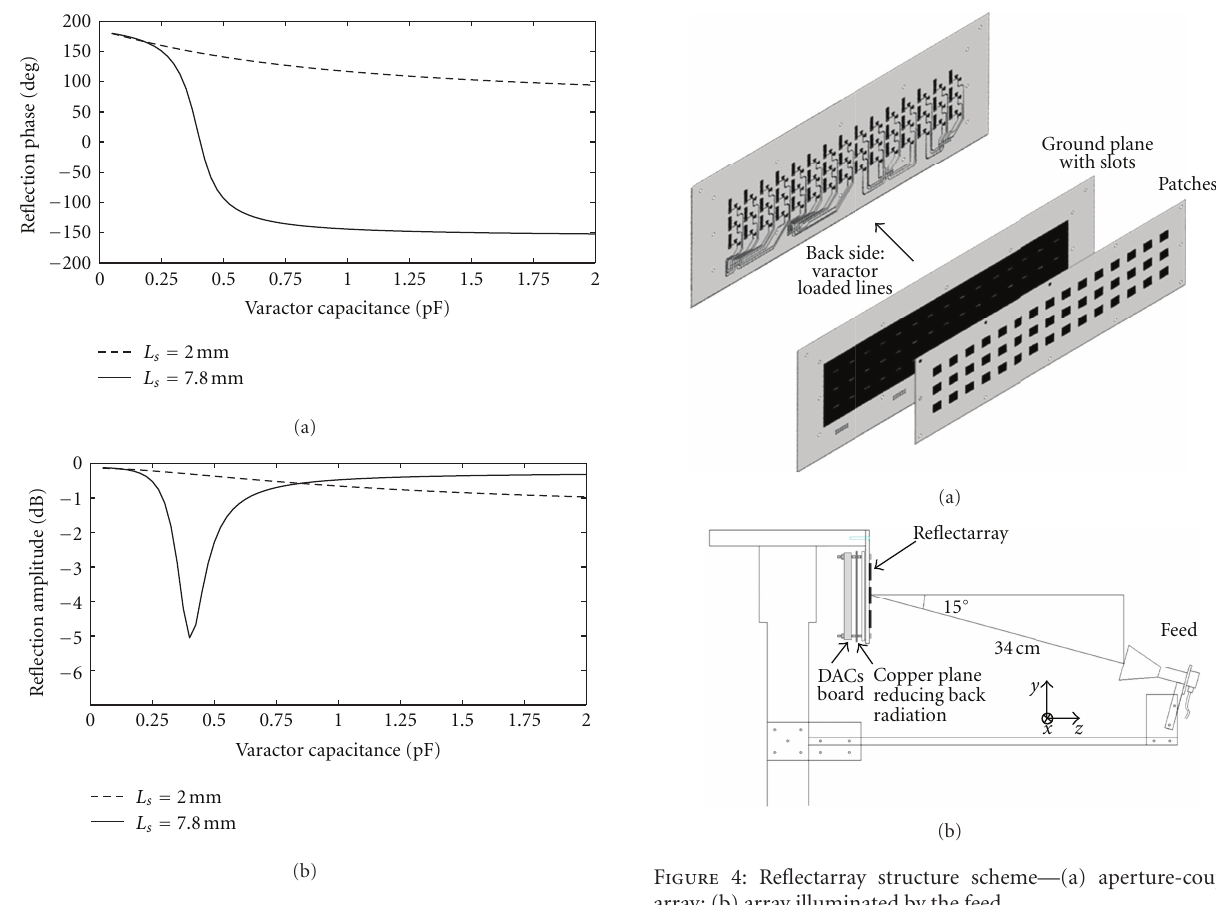
Figure 3: Simulated reflection coe ffi cient for a normally incident plane wave: phase (a) and amplitude (b) versus varactor capacitance for di ff erent stub lengths.